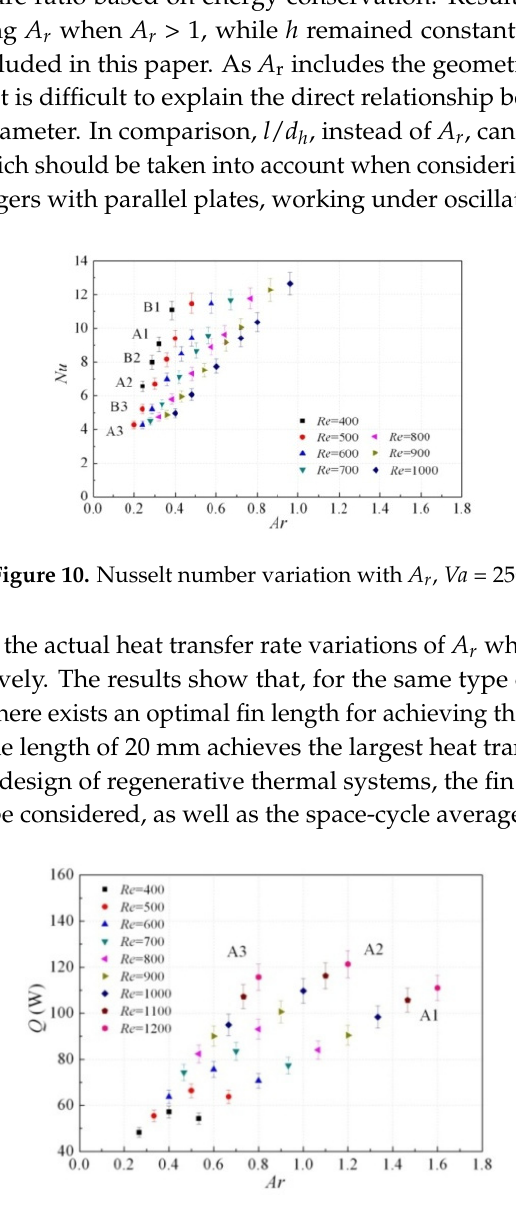
Figure 9. Nusselt number variation with A r , Va = 200.